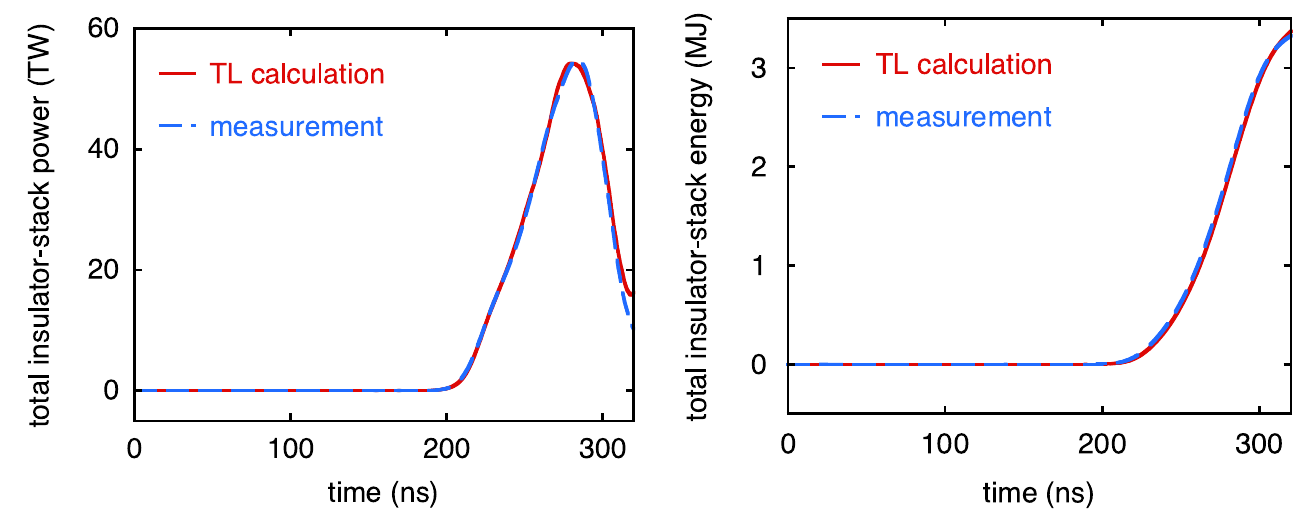
FIG. 7. (Color) Comparison of the TL -calculated total electro- magnetic energy at the insulator stack, with the average mea- sured total stack energy, for the seven shots taken with Z ’s baseline load. (The average is computed by summing, for each shot, the energy over each of the four levels, then taking an average over the